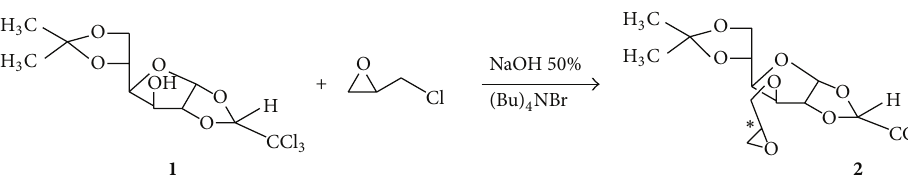
Figure 5: The possible reactions of compound 2